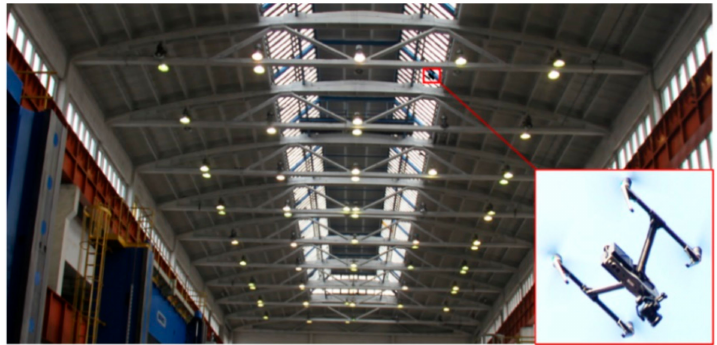
Figure 4. Visual inspection using an unmanned aerial vehicle (UAV).